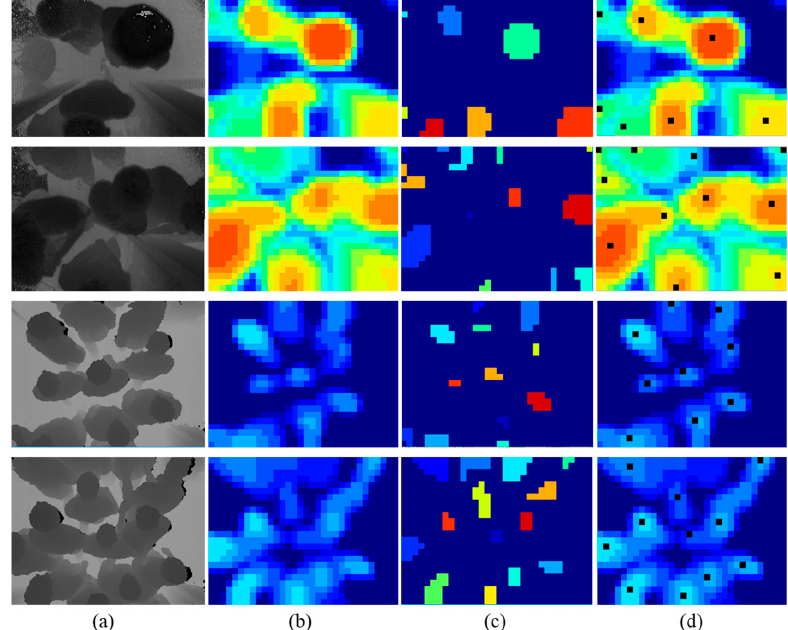
Figure 4. Local pooling and searching. ( a ) The input depth images from simple to complex scenes; ( b ) visualization of pooled images; ( c ) visualization of local searching and connect component labelling; ( d ) results of the human detection module.